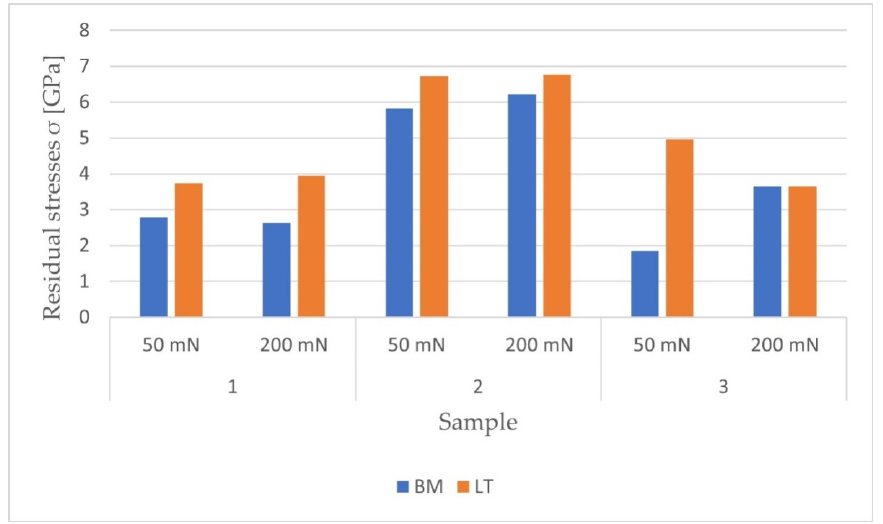
Figure 11. Residual stresses obtained at a depth of 300 nm from the surface of the materials.